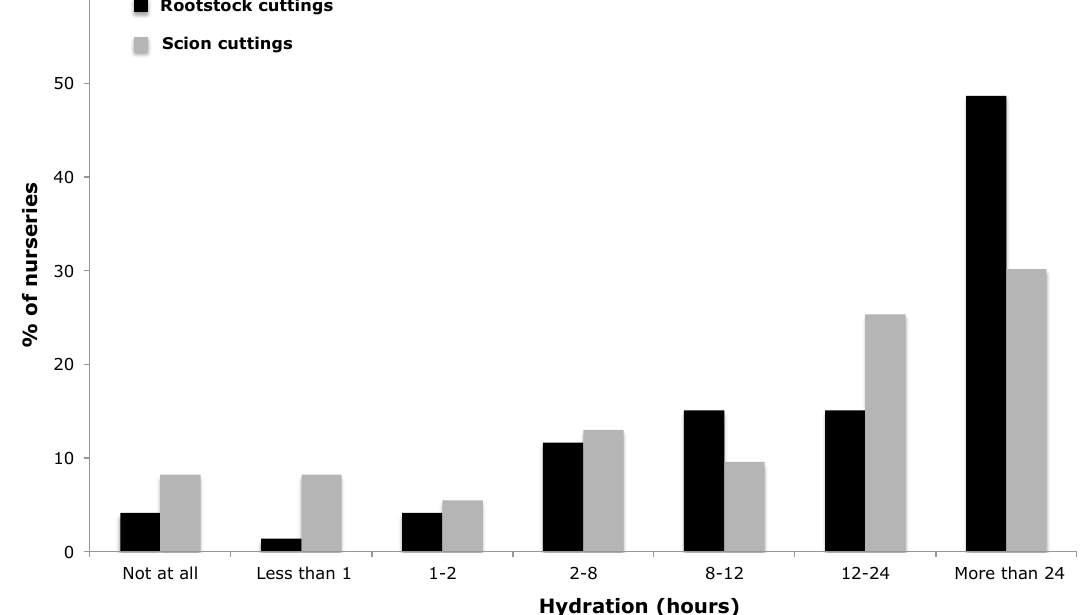
Figure 1. Duration of the hydration process of rootstock and scion cuttings after cold